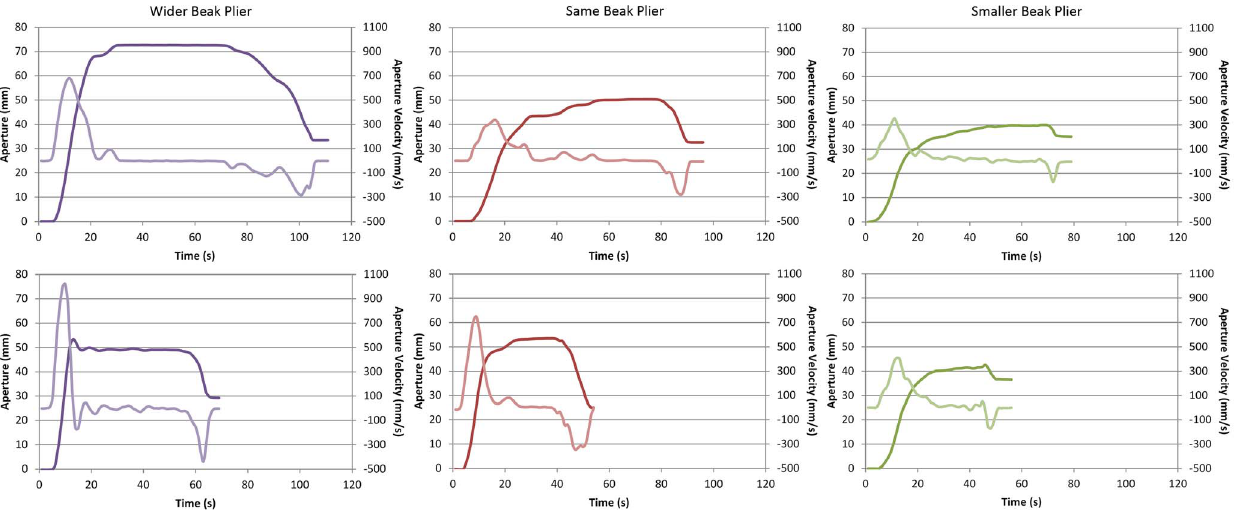
Figure 2. Grasping patterns of three different individuals each using a different pairs of pliers. The top row shows grasping patterns from beginning of the first practice sessions and the bottom row from the end of the second practice session. The aperture profile is the dark line and the aperture velocity is the light line.